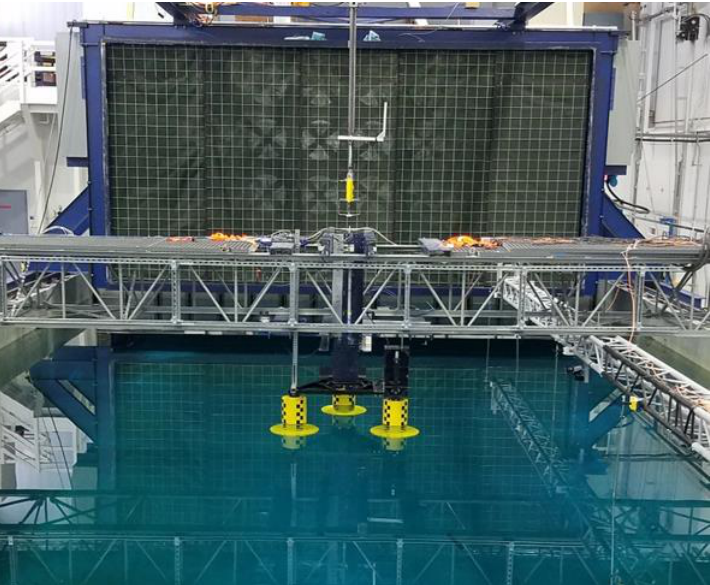
Figure 2. View towards the wavemaker in the W2 wave basin at the University of Maine showing the component model. Photo reproduced with permission from Matthew Fowler, 1/50-scale DeepCwind semi-submersible component wave testing [5]; published by the University of Maine, 2021.